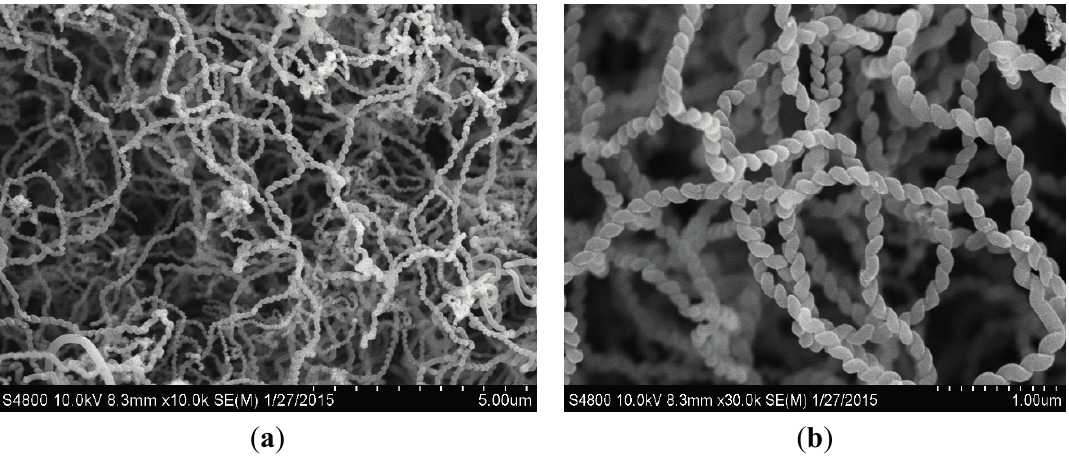
Figure 6. SEM micrographs of carbon-nanocoils at ( a ) low magnification and ( b ) high